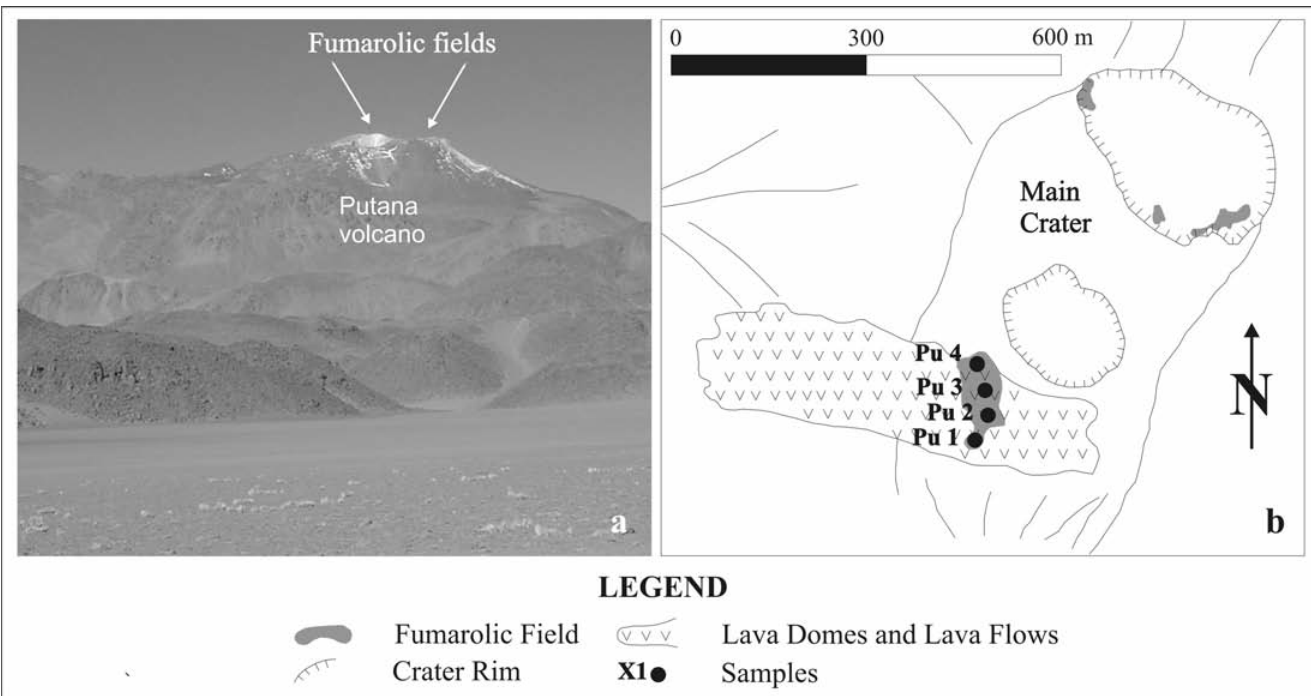
Figure 4. Photograph (a) and schematic map (b) of the summit crater of Putana volcano, showing the locations of the fumarolic fields and sampling sites.